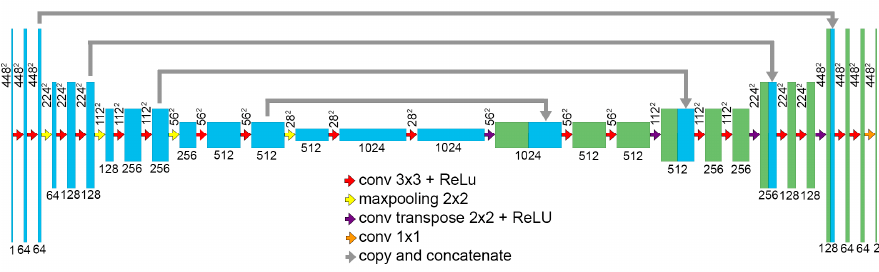
Figure 2. Segmentation network.